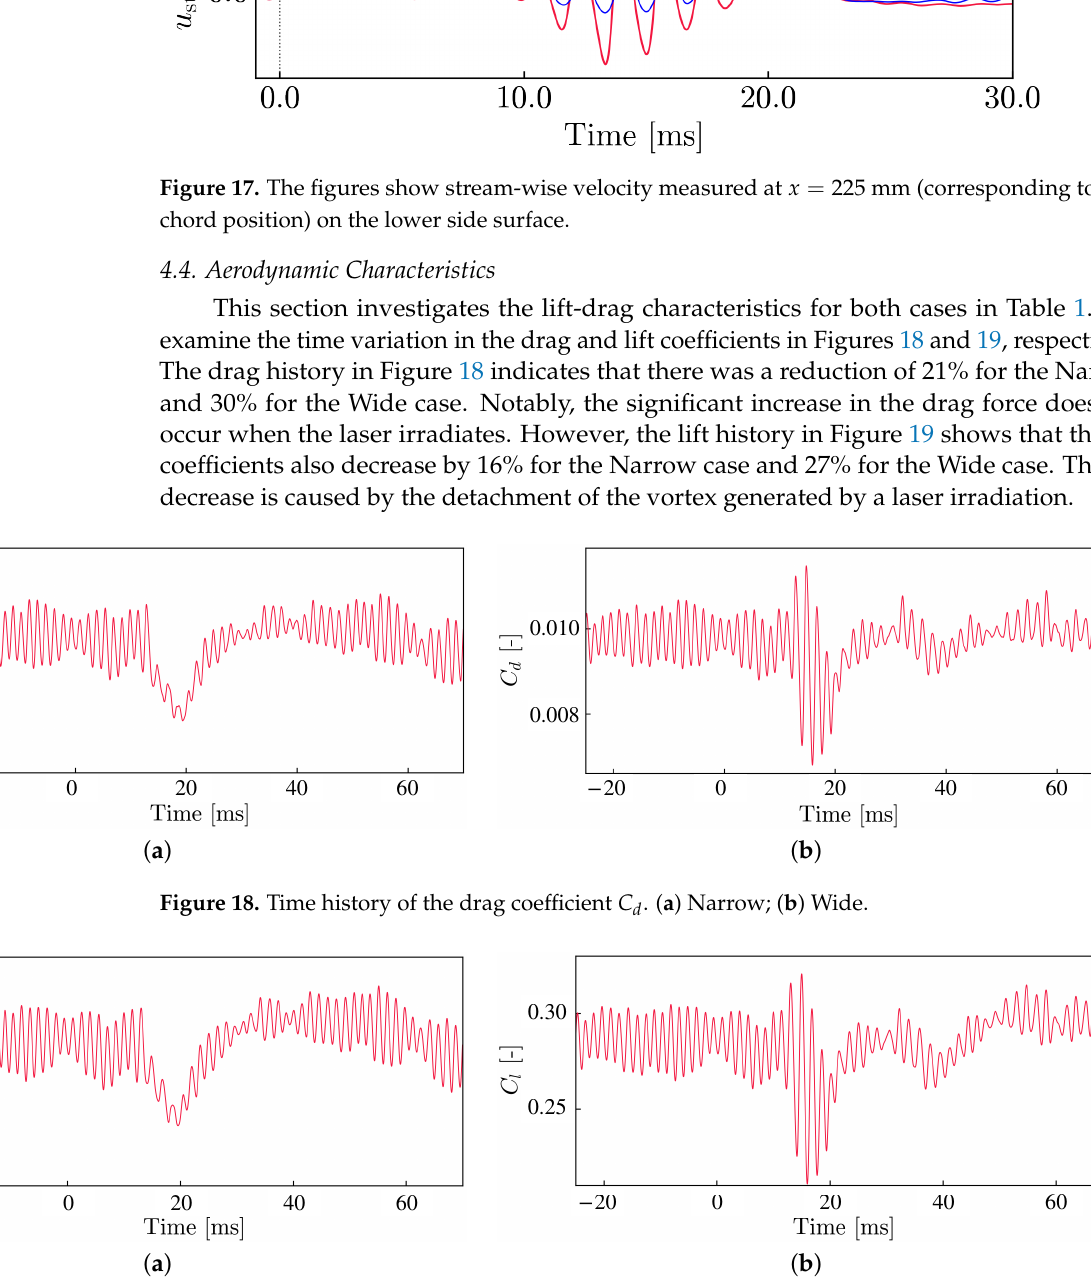
Figure 19. Time history of the lift coefficient C l . ( a ) Narrow; ( b )